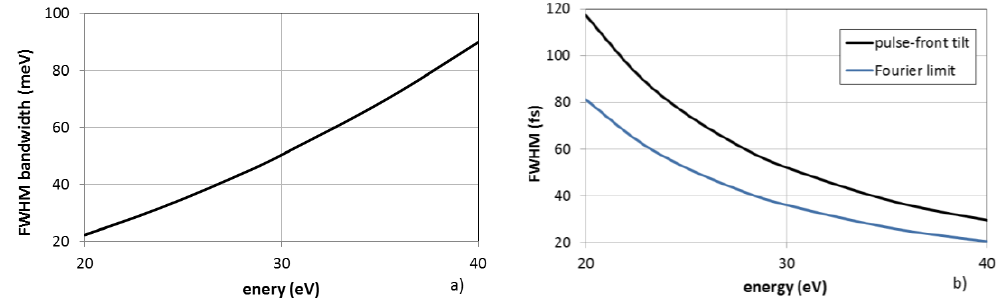
Figure 4. OPM ultrafast monochromator with a Gaussian diffraction-limited input source, 100 μm